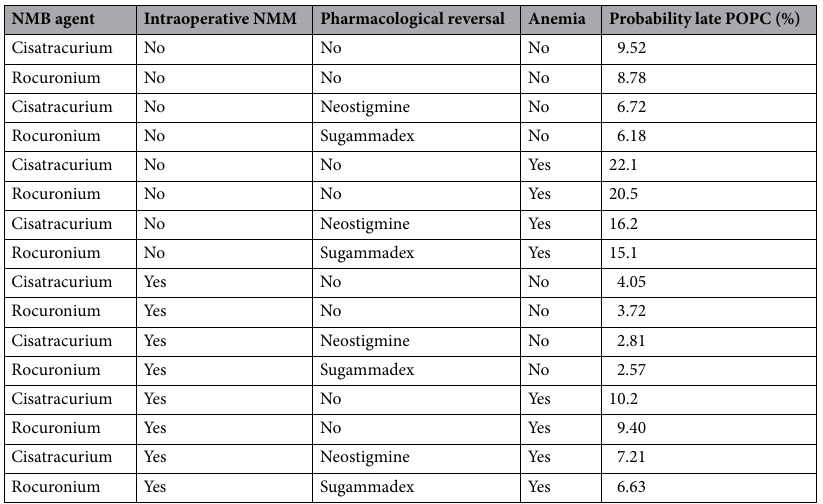
Table 6. Probability of late-onset postoperative pulmonary complications (pneumonia and atelectasis) according to anemia, neuromuscular blockade, neuromuscular monitoring and reversal (logistic regression model). The table shows, according to the previous model, the incidence of residual neuromuscular blockade for all the possibilities of the neuromuscular blocking drug, neuromuscular monitoring, and reversal drug.